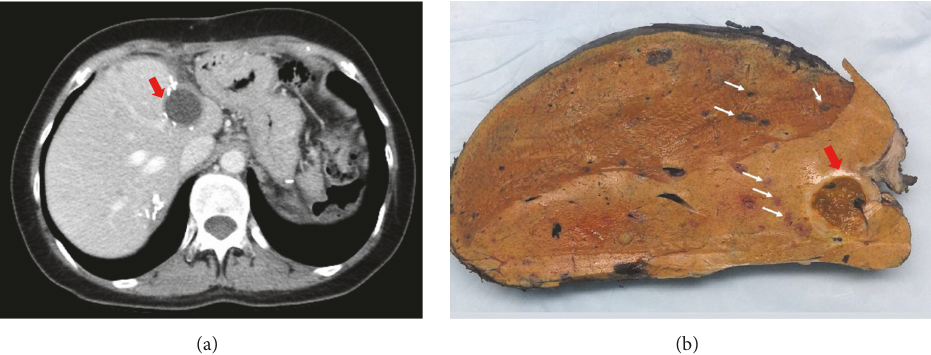
Figure 2: Epithelioid hemangioendothelioma in explant following liver transplantation. (a) Axial CT scan showing liver hemangioma (dark mass) and no obvious additional lesions. Red arrow indicates known residual hemangioma following left lobectomy. (b) Gross specimen following hepatectomy and liver transplantation. White arrows indicate multifocal EHE which was not apparent on preoperative imaging studies. Red arrow indicates corresponding lesion from (a), which demonstrated microscopic EHE within hemangioma on microscopic examination (not